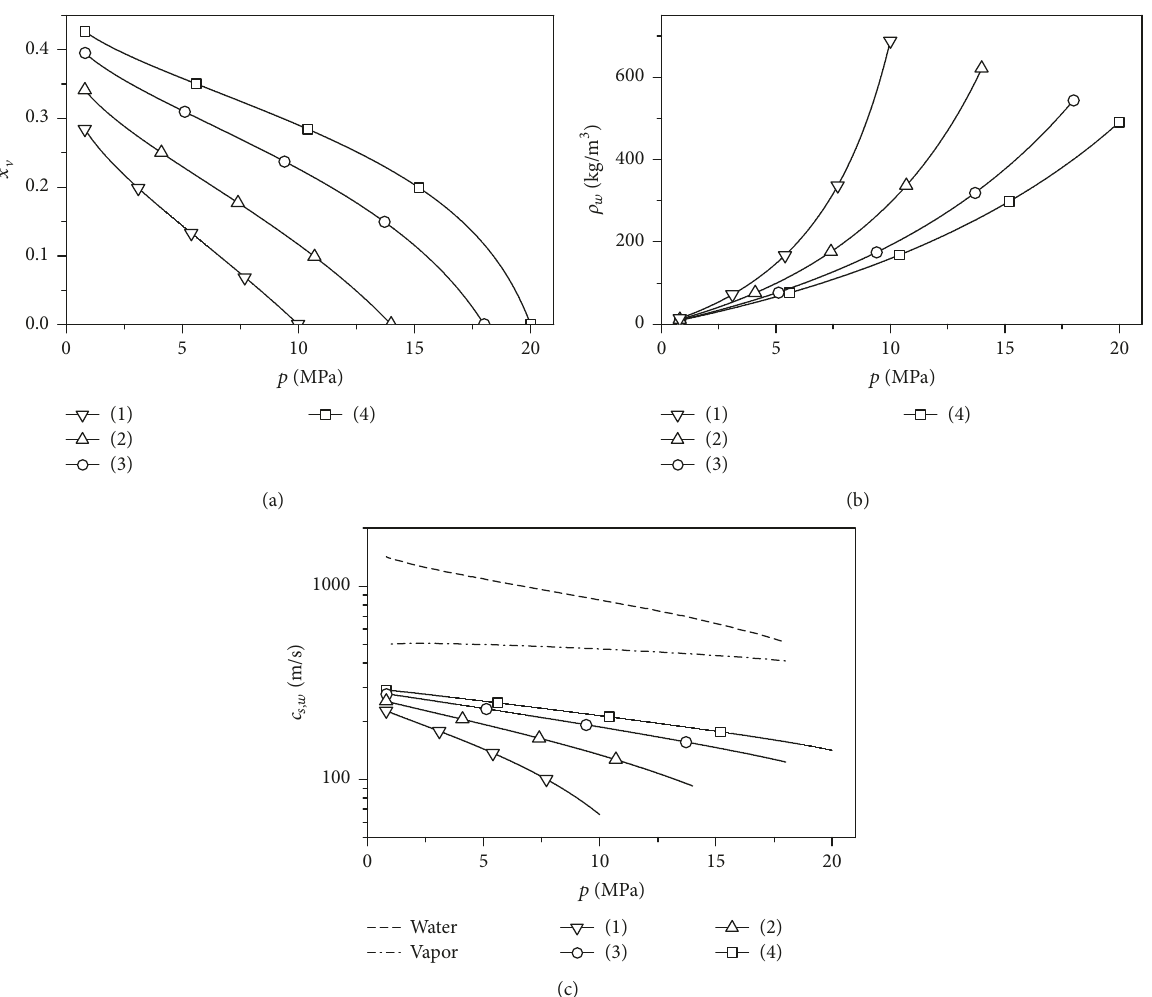
Figure 2: Calculated pressure dependencies of equilibrium water-vapor mixture properties: (a) mass fraction of vapor 𝑥 V (𝑝) ; (b) mixture density 𝜌 𝑤 (𝑝) ; (c) isentropic speed of sound 𝑐 𝑠,𝑤 (𝑝) . Curves ( 1 ) – ( 4 ) correspond to initial pressure 𝑝 𝑤,0 = 10 , 14, 18, and 20 MPa; dashed curves are speeds of sound in single-phase liquid and